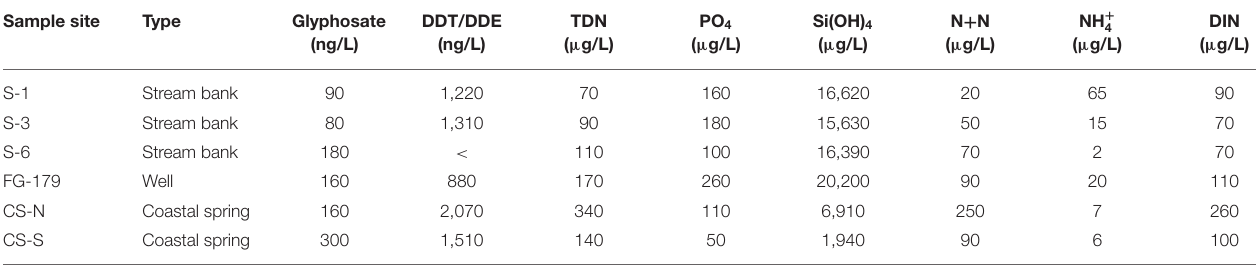
TABLE 1 | Groundwater nutrient and pesticide concentrations. Sample